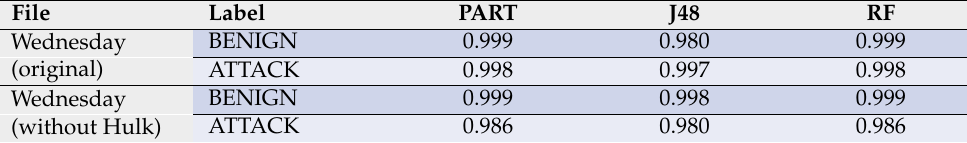
Table 21. F1 performance results using Zeek over different labelling corrections in Wednesday